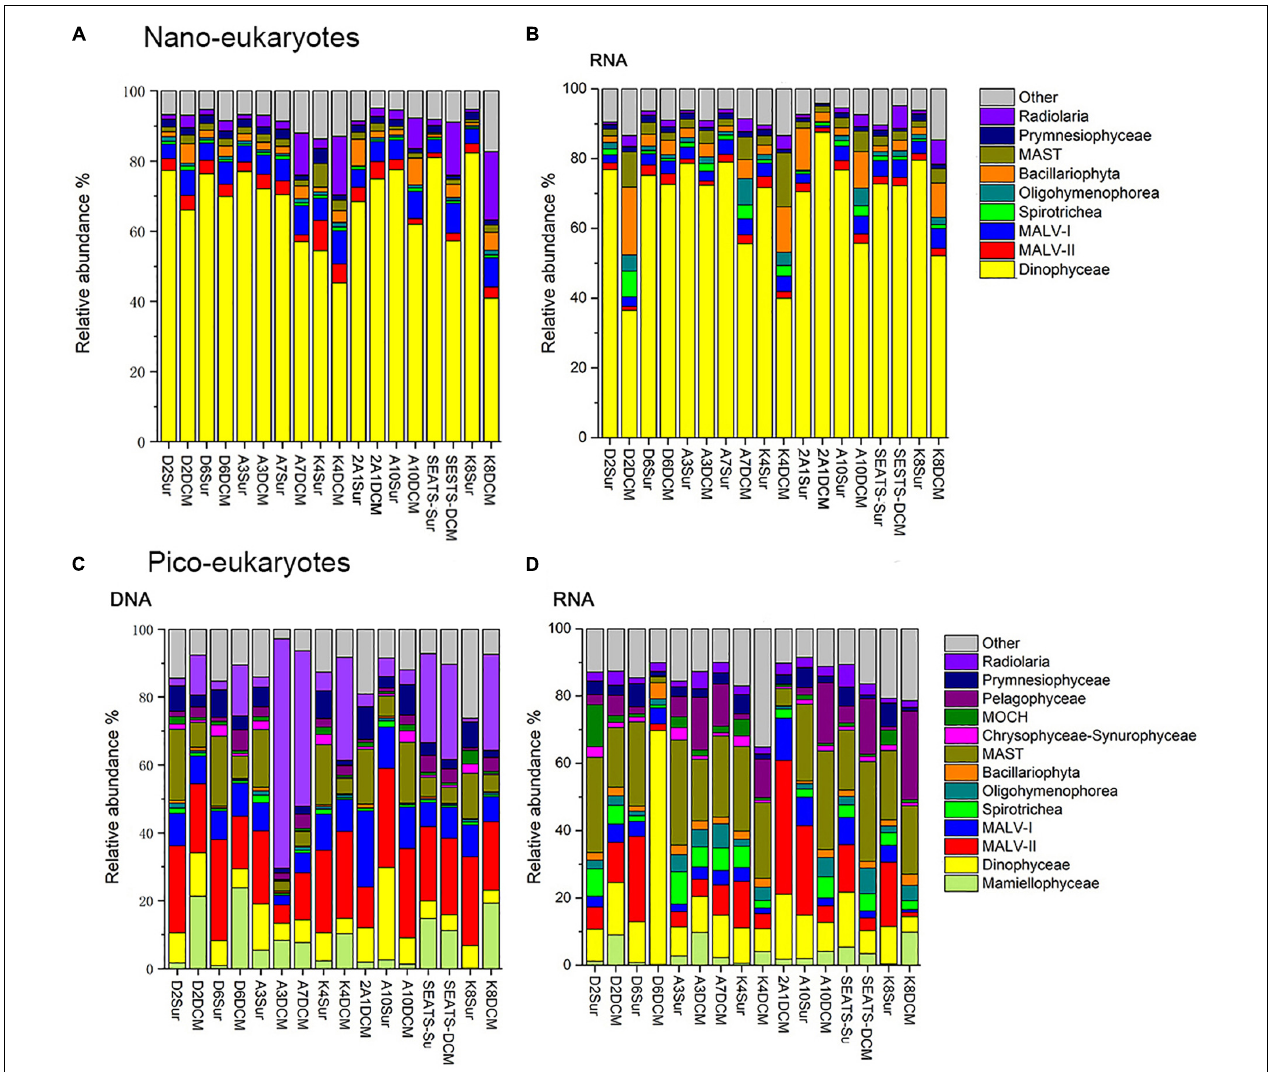
FIGURE 3 | Relative read abundance of nanoeukaryotes (A,B) and picoeukaryotes (C,D) mainly at class level based on the DNA-derived (A,C) and RNA-derived (B,D) approaches for each sample. The other category refers to groups with relatively lower sequence abundance.